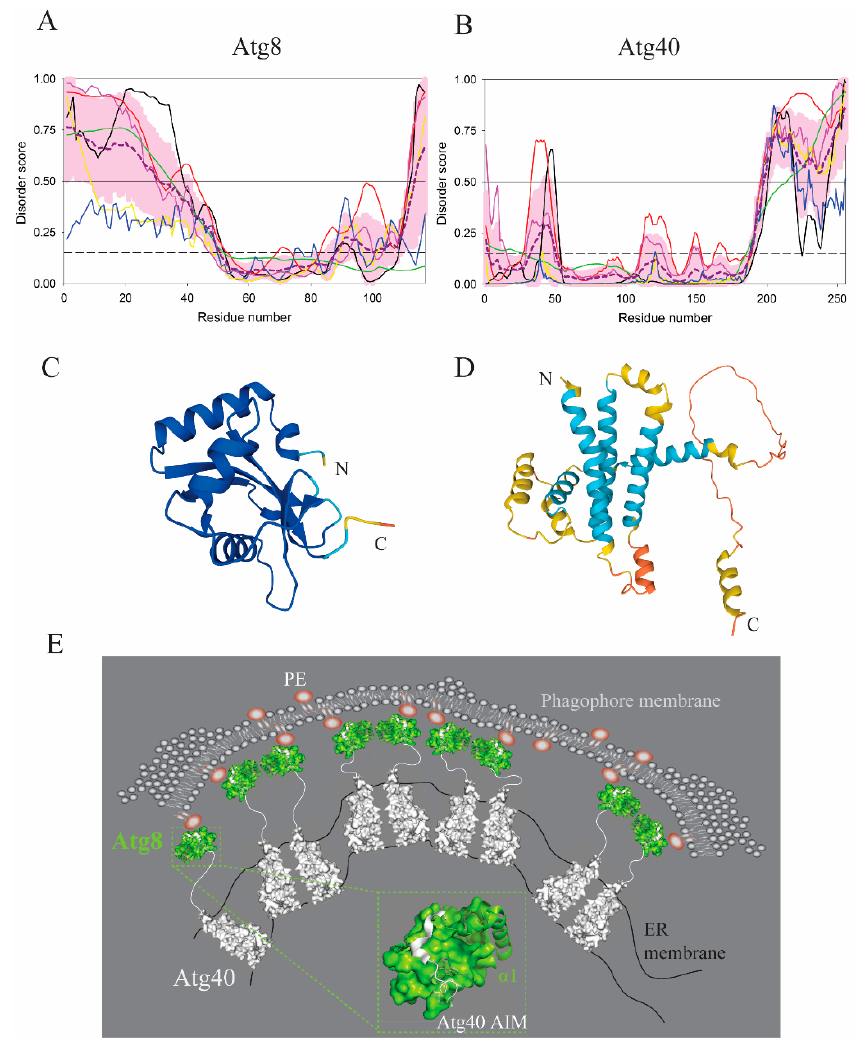
Figure 9. ER-membrane remodeling induced by the Atg40–Atg8 interaction. ( A , B ) Bioinformatics analysis of the amino acid sequences of Atg40 and Atg8 showed that the long IDPRs are located at different sides of these proteins, with the C- and N-terminal regions of Atg40 and Atg8 being disordered, respectively. Based on their overall disorder contents of 28.9% and 37.6%, Atg40 and Atg8 are classified as moderately disordered. ( C , D ) The AlphaFold models of the Atg40 and Atg8 structures with color-coded modeling confidence. Very high confidence, blue; high confidence,